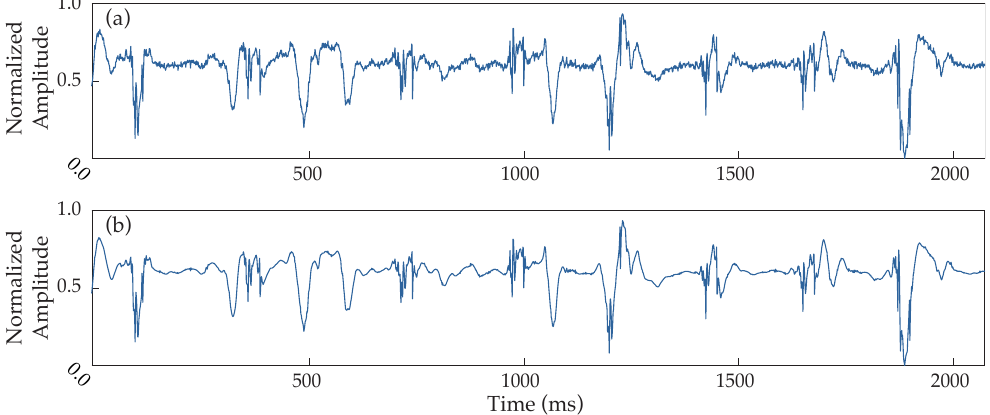
Figure 2. Example of noise filtering performance applied to a noisy EGM. ( a ) Normalized raw electrogram, ( b ) electrogram denoised by the stationary wavelet